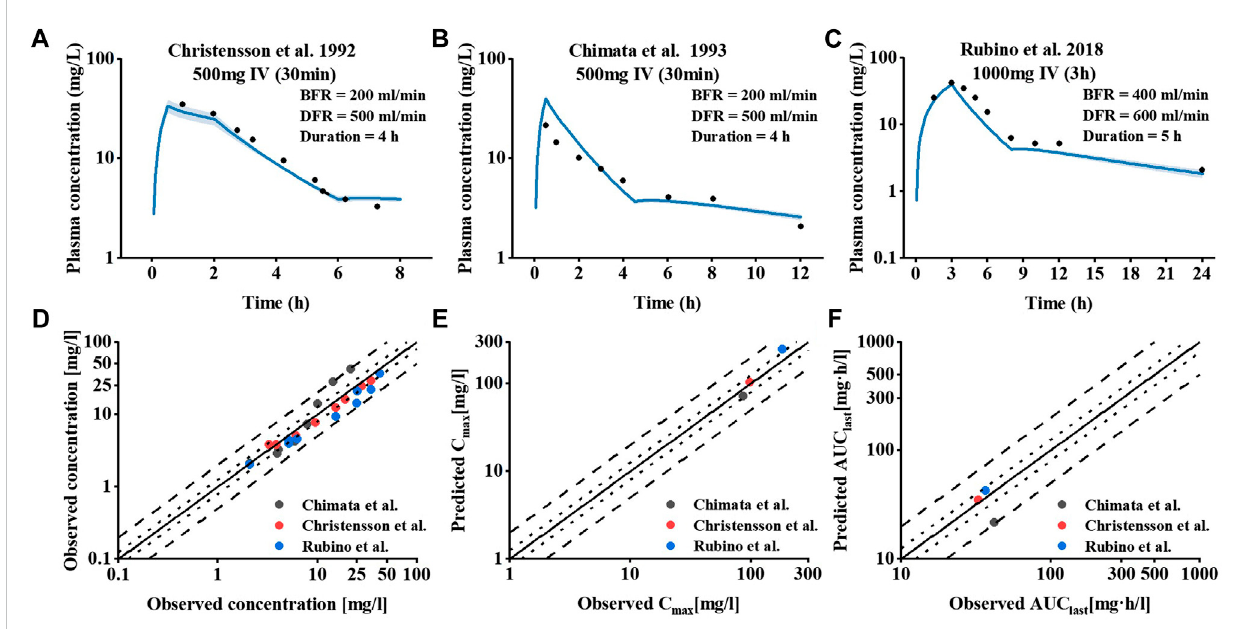
FIGURE 4 Meropenem plasma concentration and model performance in patients receiving IHD. (A – C) Simulated and observed plasma concentration – time pro fi lesatdifferentdialysis parametersettings.The shaded areaindicatesthecorresponding standarddeviation(SD) for thesimulated data, and theblack circles represent the mean observed concentration for each respective study. (D – F) Meropenem hemodialysis model performance.